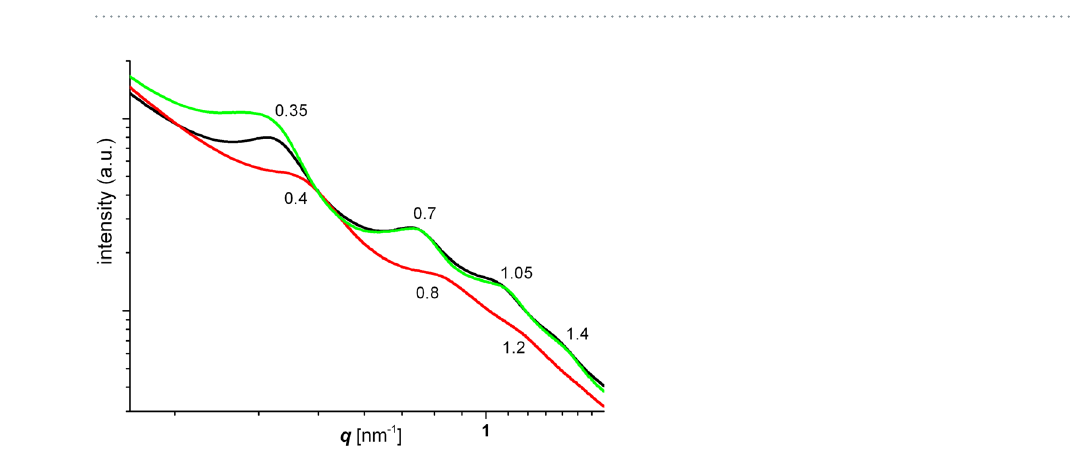
Figure 3. Sections of SAXS curves for LDH-NC films from PES-NB (black), b-HBA (green) and b-PES (red, cf. Fig. 2 for TEM images). Values for the scattering vector q indicate hump